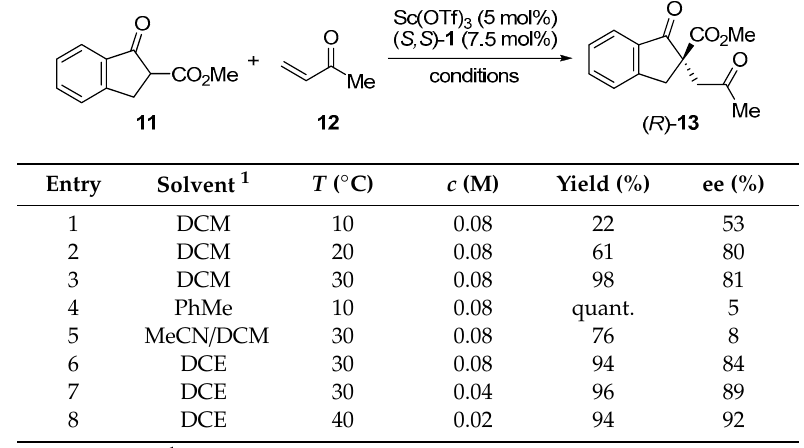
Molecules 2019 , 24 , x FOR PEER REVIEW Table 3. Michael addition of β -ketoester 11 to methyl vinyl ketone (MVK) 12 .